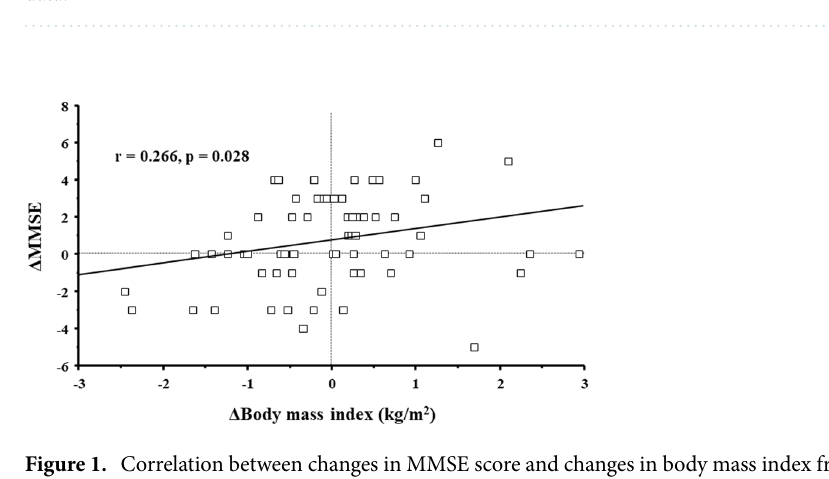
Table 2. Correlation between changes in MMSE and those in clinical parameters during this study. eGFR estimated glomerular filtration rate, Hb haemoglobin, MMSE Mini-Mental State Examination, rSO 2 regional oxygen saturation. *Statistically significant. # Indicates spearman’s rank correlation for skewed distribution of data.